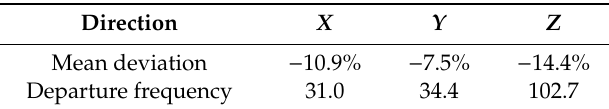
Figure 6. Comparison of the longitudinal attenuation results from the SOA model and the Born approximation [40] for a textured Ti polycrystal of triclinic crystallites with mean grain radii a X = a Y = a Z = 0.1 mm . The macrotexture parameters are σ θ = 0.03, σ φ = σ θ and σ ζ = 3 σ θ . Rayleigh region, k L a X < 0.2; geometric region, k L a X > departure frequency (given in Table 3); estimated stochastic region, 10 < k L a X < departure frequency. Table 3. The mean deviation between SOA and the Born approximation below break frequency (SOA model is treated as reference) and the break frequency k L a X of the Born approximation for a textured polycrystal with equiaxed Ti grains.